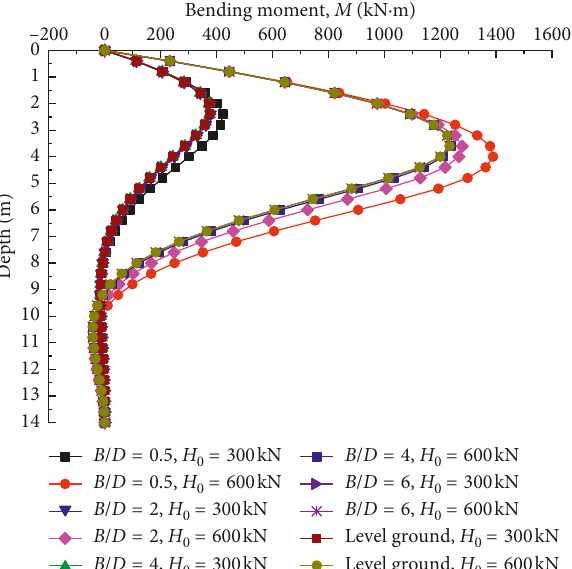
Figure 19: Bending moment variation along the depth of pile for θ 30 ° for different slope angle. (cid:31)